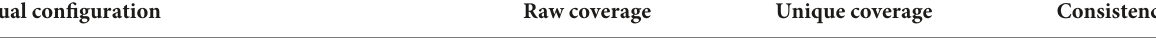
TABLE 6 Results of both the parsimonious and intermediate solution of Low_TP. Casual